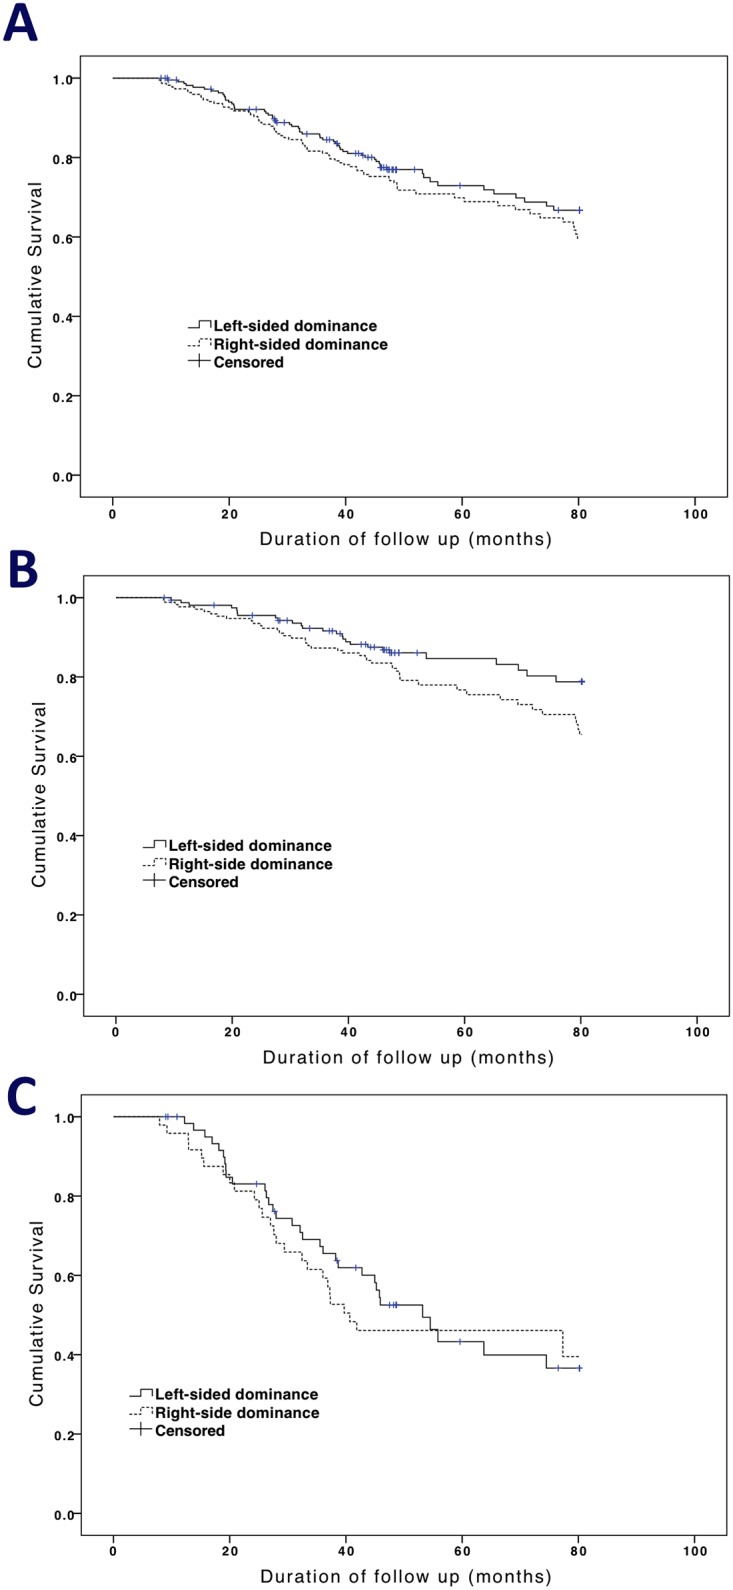
Probabilities of overall survival according to dominance side of ABI value.(A) in all patients with log-rank test: χ2 = 1.32; P = 0.249; (B) in patients without PAOD with log-rank test: χ2 = 3.47; P = 0.062; (C) in patients with PAOD with log-rank test: χ2 = 0.20; P = 0.651.